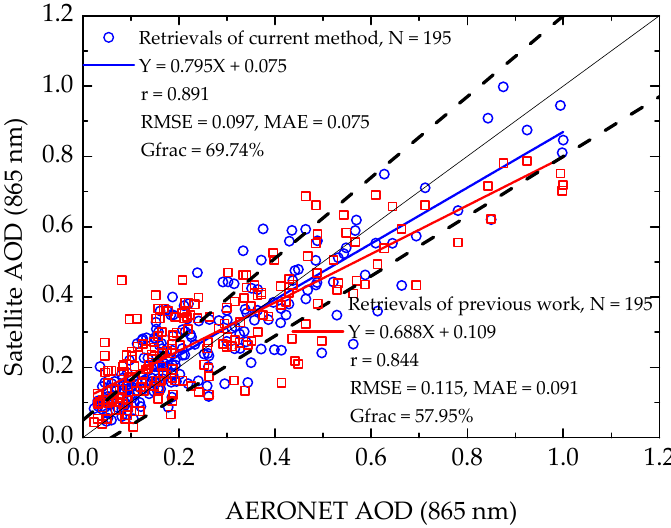
Figure 6. Comparison of results from the current and previous methods at the Beijing and Xianghe sites. Table 1. Statistical results of the mean AERONET and retrieved AOD (865 nm). MAE, mean absolute error.